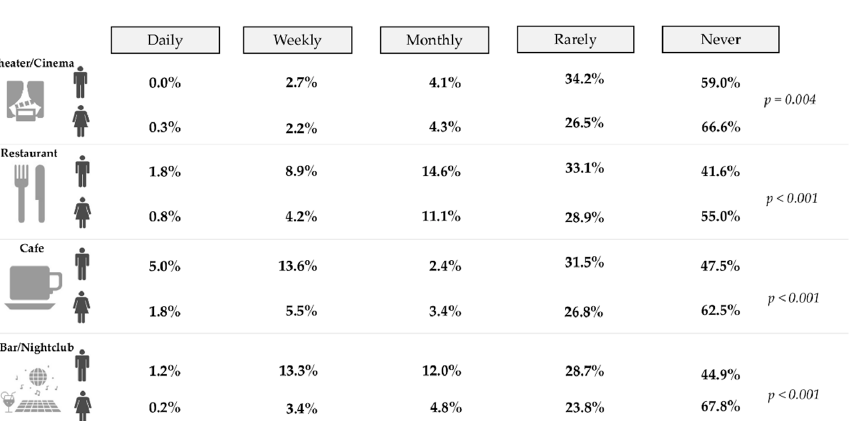
Figure 3. Frequency of the recreational activities among urban area in each age group ( p, p -value ). As presented, significant differences were observed in the performance of all recreational activities among participants of the same age group living in different types